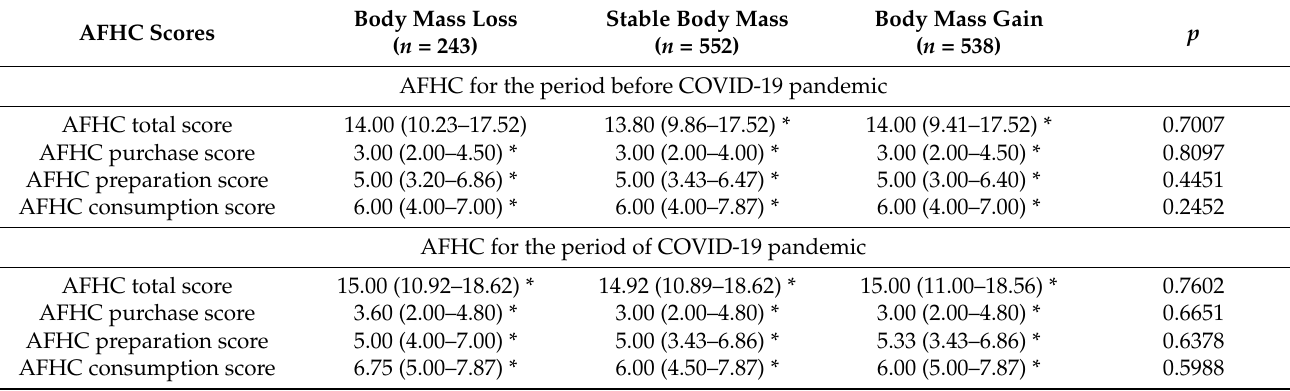
Table 3. The Adolescents’ Food Habits Checklist (AFHC) scores for the period before the COVID-19 pandemic and for the period of COVID-19 pandemic, stratified by body mass changes during the COVID-19 pandemic, for the total population of adolescents from the Diet and Activity of Youth during COVID-19 (DAY-19) Study ( n =